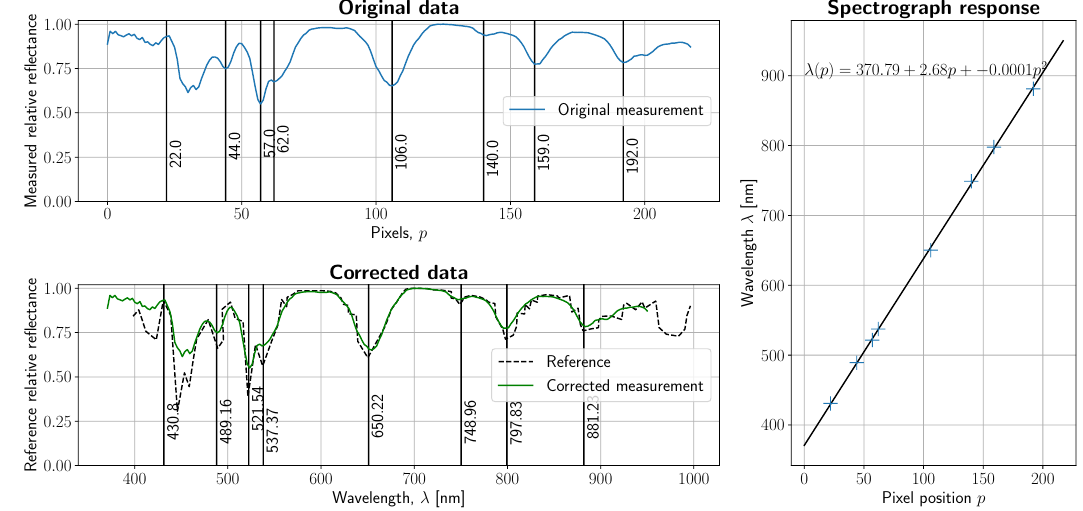
Figure 9. Spectral calibration with Wavelength Calibration Standard (WCS) WCS-MC-020 . Top left: labeled absorption peaks in the measured reference. Bottom left: reference and measured spectra after calibration. Right: fitted quadratic polynomial with respect to labeled points.